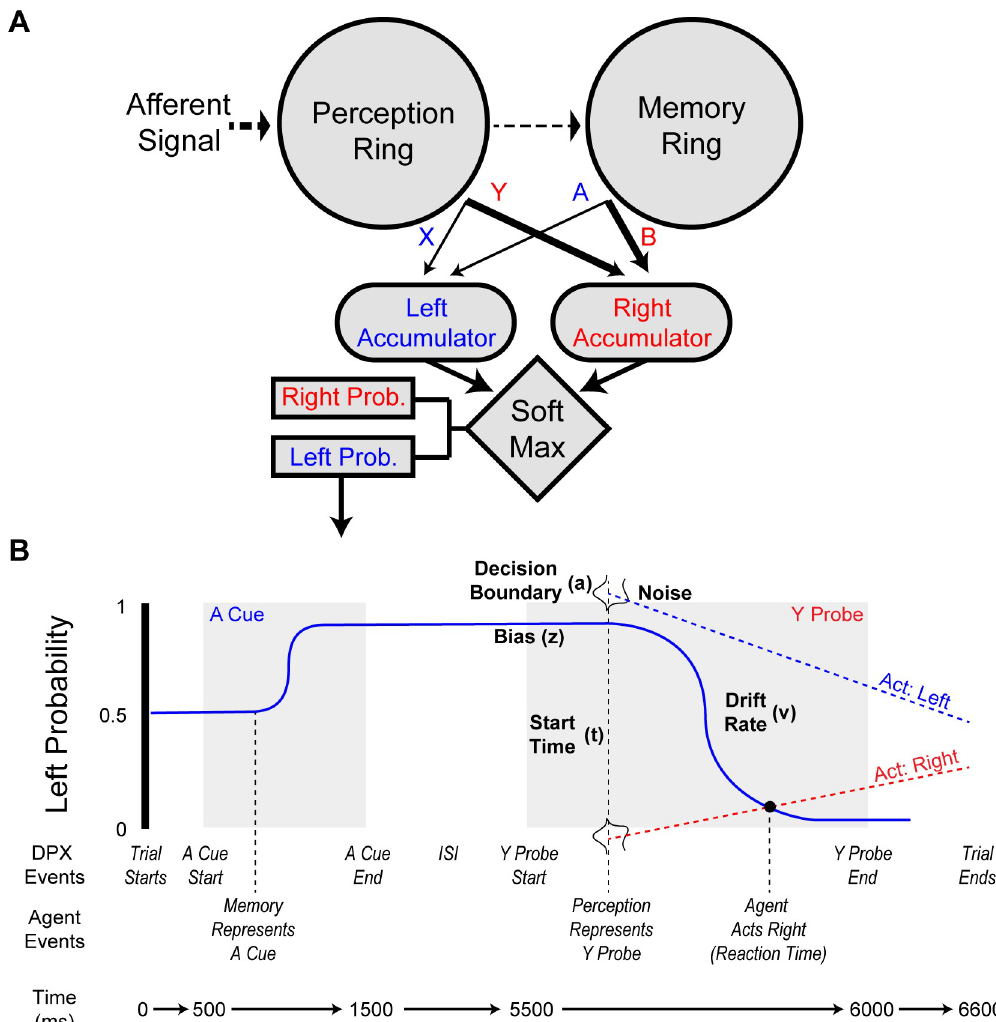
Fig 4. DPX task and agent design. A. Design of the DPX agent. The agent was comprised of perception and memory ring attractors that represented the current stimuli and the context, respectively (due to their underlying EI balances). Both ring attractors were structurally identical to the one specified in Fig 2B. The perceptual network’s pyramidal outputs projected weakly to the memory ring, providing its representational inputs. As with the ring attractor in Fig 2B, certain areas of the ring represented the cue and probe stimuli. How well the cue and probes were represented in the networks was used to inform the agent’s decision making process. Pyramidal cell activity in the ring attractors projected to leaky left and right response accumulators that utilized a softmax decision making algorithm to determine the agent’s likely response to the probe. Connection weights to the left accumulator (i.e., A from the memory ring and X from the perception ring) are weaker than those to the right accumulator (i.e., B from the memory and Y from the perception ring), because the representations of B and Y needed to override the A and X representations during decision making. B. Temporal structure of an AY DPX trial and how the agent’s decision making process changed in response to task events. The gray regions indicate when the cue and probe were presented (not to temporal scale). As the agent represented information about the cue and probe, its likelihood of engaging in a left or right response changed. For example, representation of the A cue caused the agent to be much more likely to engage in a left action, but as the Y probe information was represented, the agent became unlikely to engage in a left action. A drift-diffusion-like decision process was used to determine the timing and choice of the agent’s actions. As soon as the agent’s perception network represented the probe (X or Y), it initiated its decision making process. When a collapsing left or right response boundary crossed the left action probability, the agent engaged in the associated action at that time. This decision making process did not formally specify drift-diffusion-model-like dynamics, with the exception of the decision boundaries ( a ). However, the decision making process’ created similar constructs. How the components of this process are akin to an evidence accumulation process are identified with the terms and parameters (indicated a , t , v , and z ) that are commonly used in the DDM